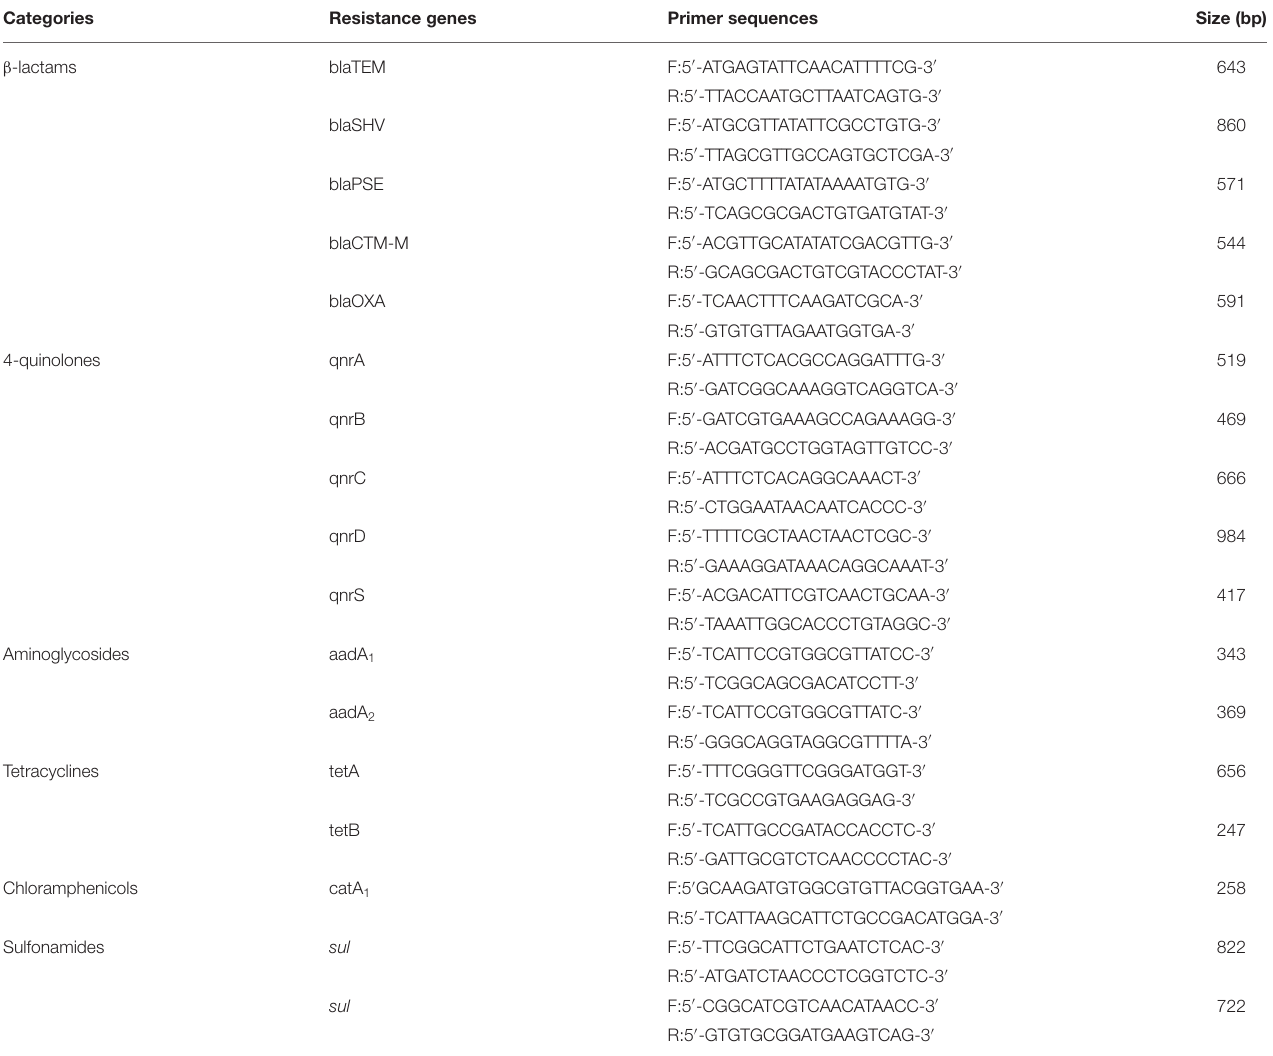
TABLE 2 | Primer sequence for PCR of resistance